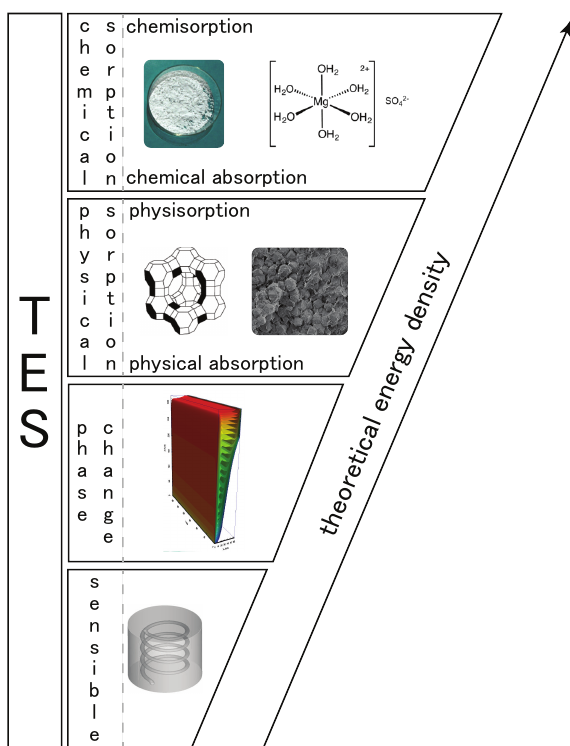
Figure 2. Classification of heat storage by physical